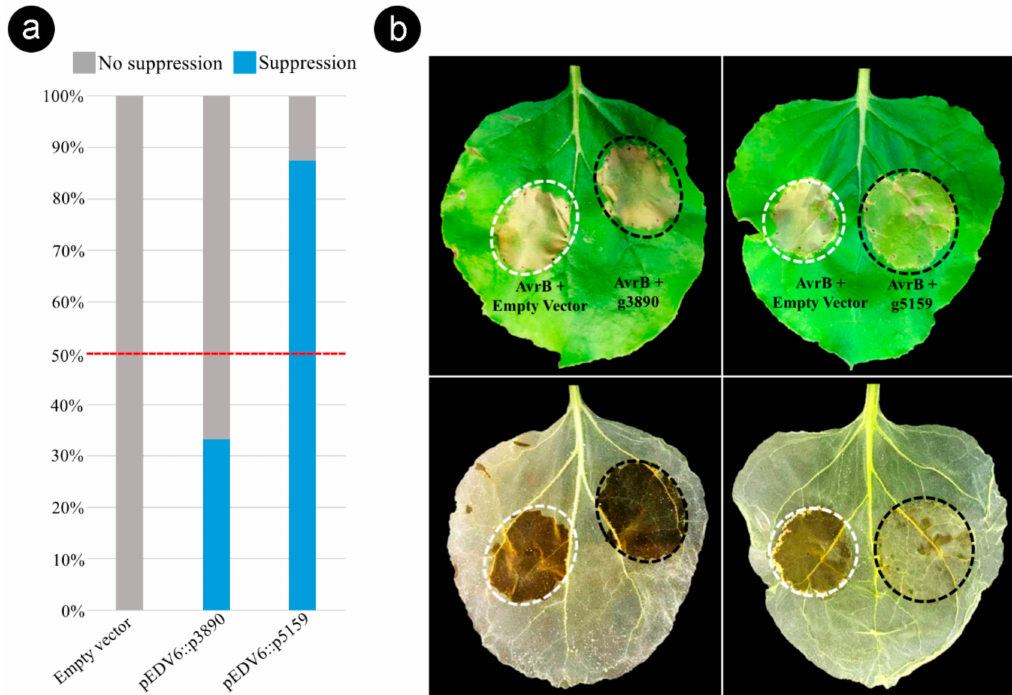
Figure 6. Sporisorium scitamineum e ff ector candidate g5159 suppresses AvrB-induced e ff